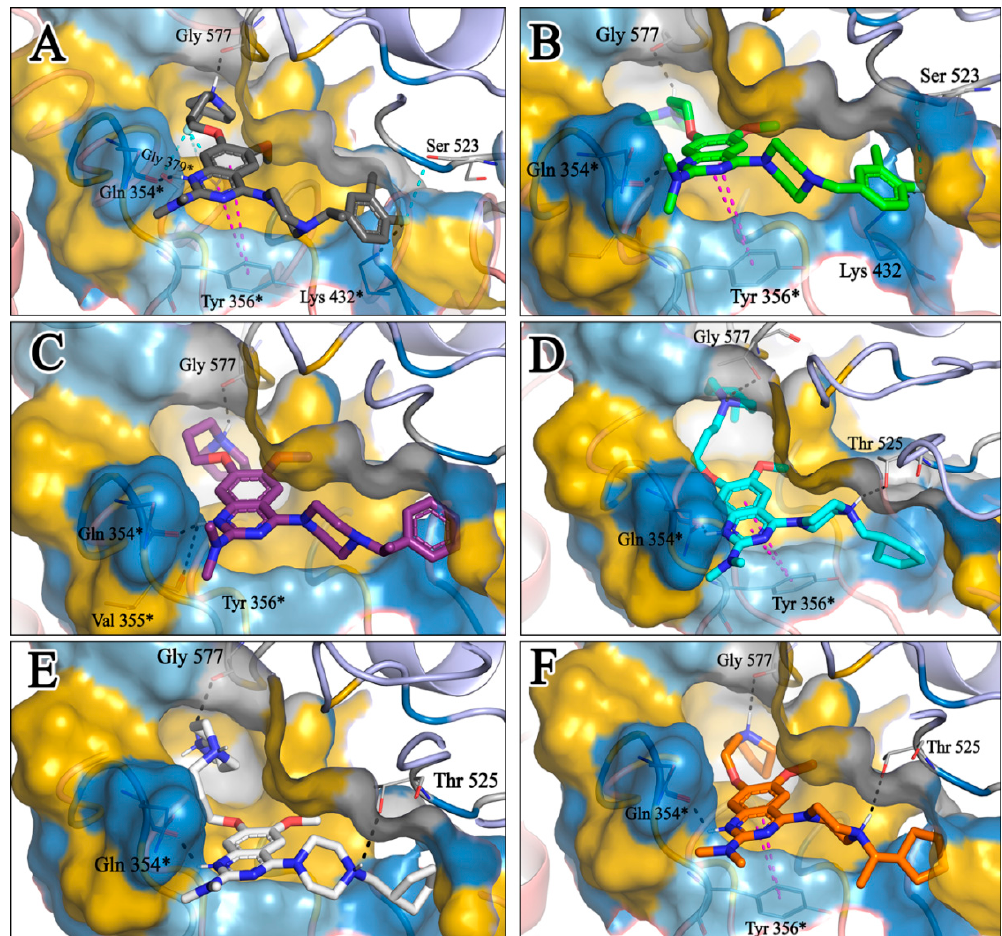
Figure 17. ( A – F ). Binding poses of compounds T60 , T56 , T55 , T66 , T59 , and T58 , respectively, into the proposed active site. Hydrogen bonds are indicated with black dotted lines, whereas purple dotted lines mean π – π hydrophobic interactions, and cyan dotted lines indicate halogen bonds.